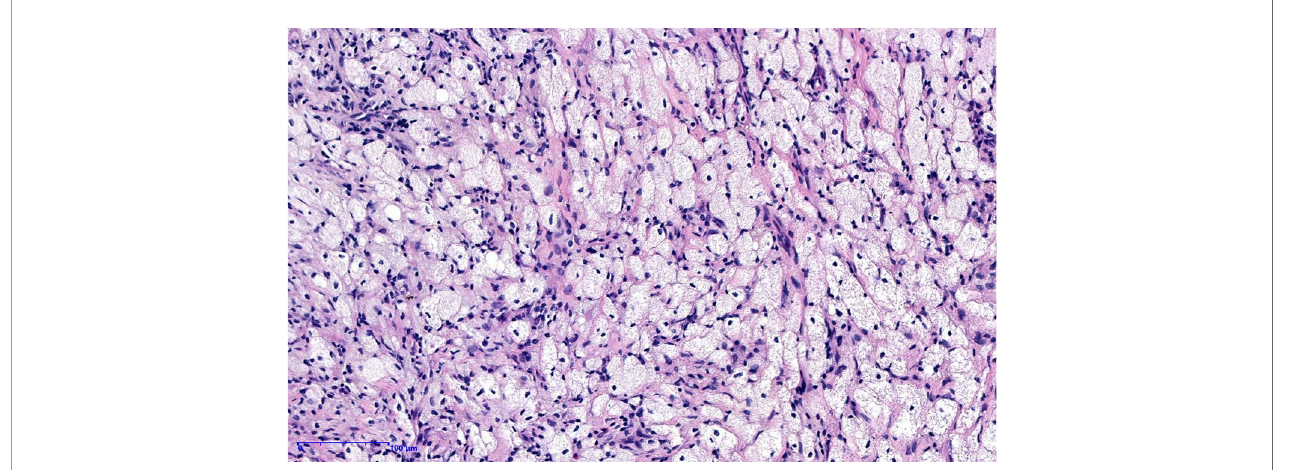
FIGURE 4 | Histopathological image showing fi brocollagen hyperplasia with lymphocyte in fi ltration and foamy histiocytic